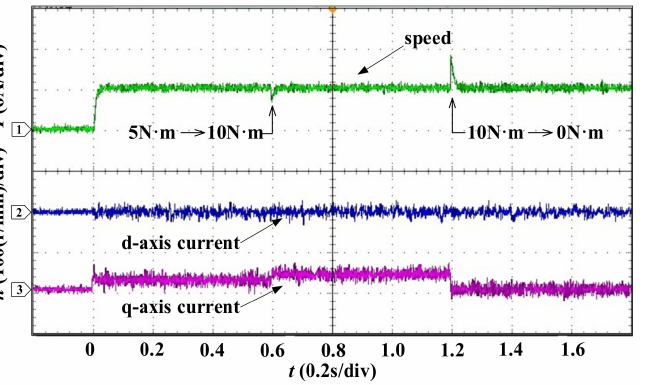
Figure 7. Experimental results of motor load variation under second-order sliding mode control